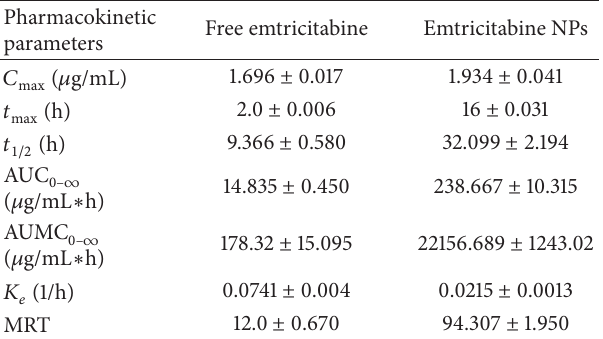
profile of emtricitabine NPs when compared with free emtric- itabine (Figure 6). The concentration values of drug versus time, for free emtricitabine and emtricitabine NPs, were subjected to two-tailed unpaired t -test and the 𝑃 values ( ∗∗∗ 𝑃 < 0.001) indicated extremely significant difference.